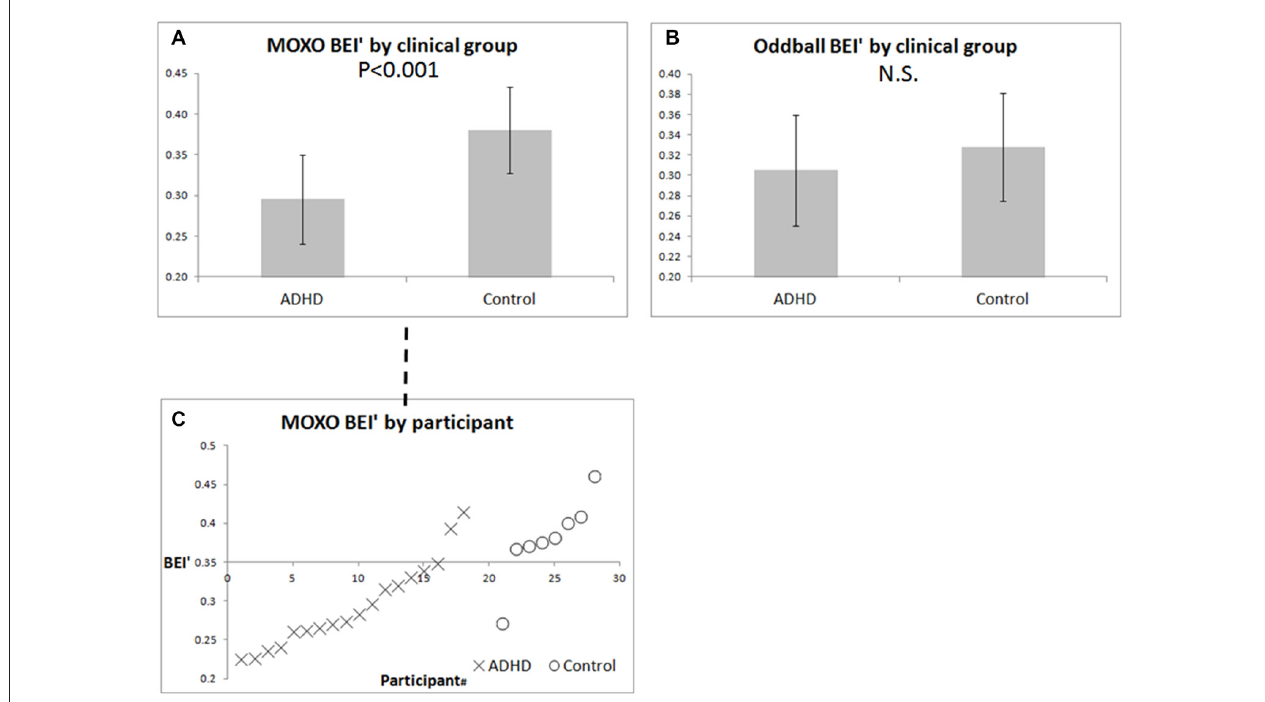
FIGURE 4 | BEI’ of ADHD patients and controls during pre-treatment MOXO and auditory oddball. (A) Mean ± standard deviation of BEI’ during the pre-treatment MOXO test in ADHD patients and controls. (B) Mean ± standard deviation of BEI’ during the pre-treatment 1-min auditory oddball. (C) BEI’ during the pre-treatment MOXO by group and participant, ordered by BEI’ within each group. X = ADHD patients, O = controls.